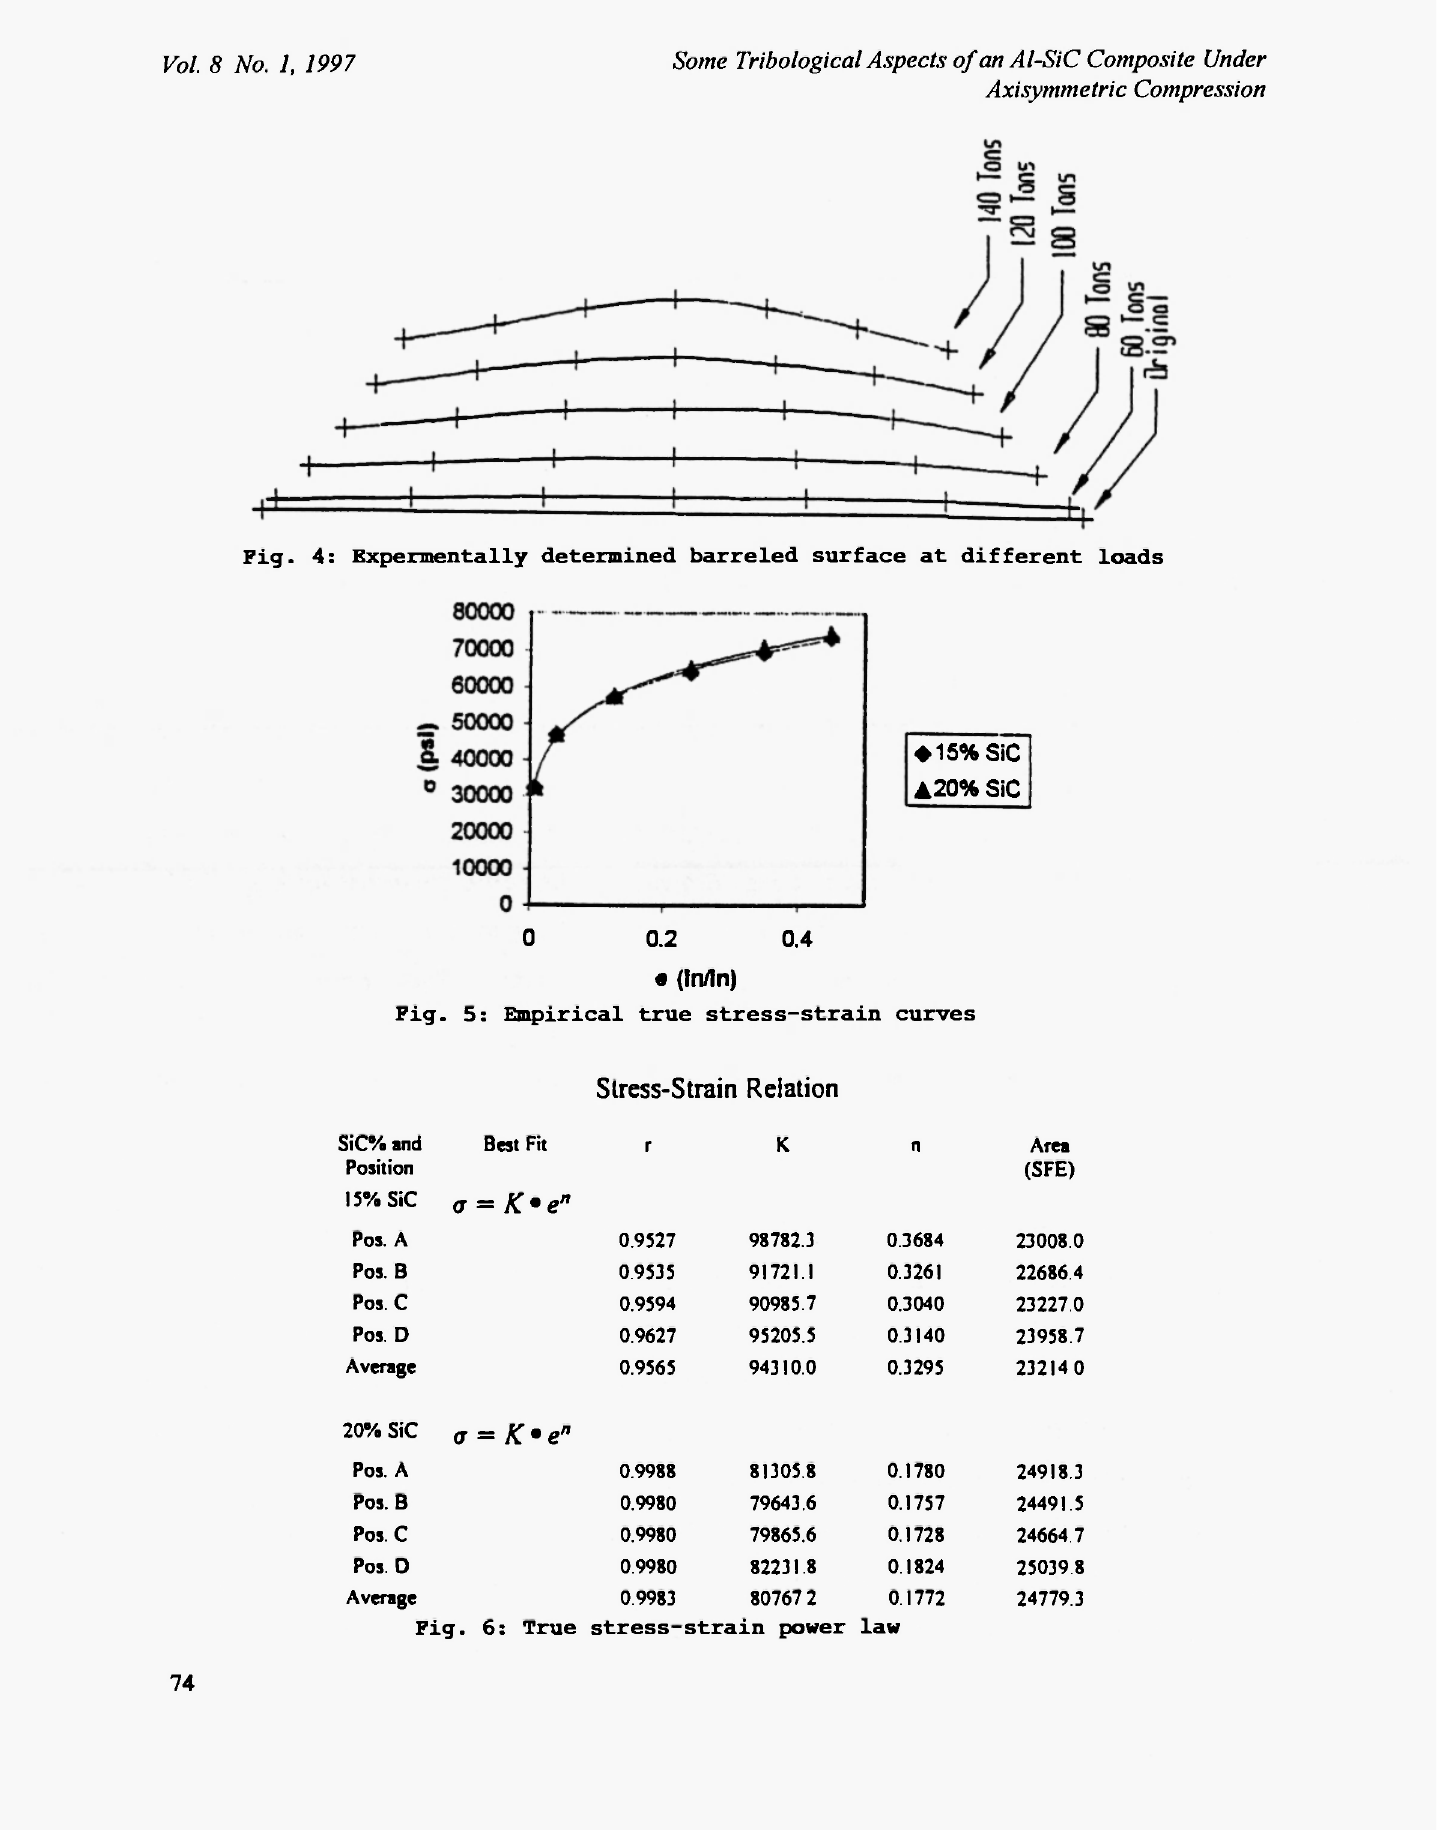
Fig. 6: True stress- strain power